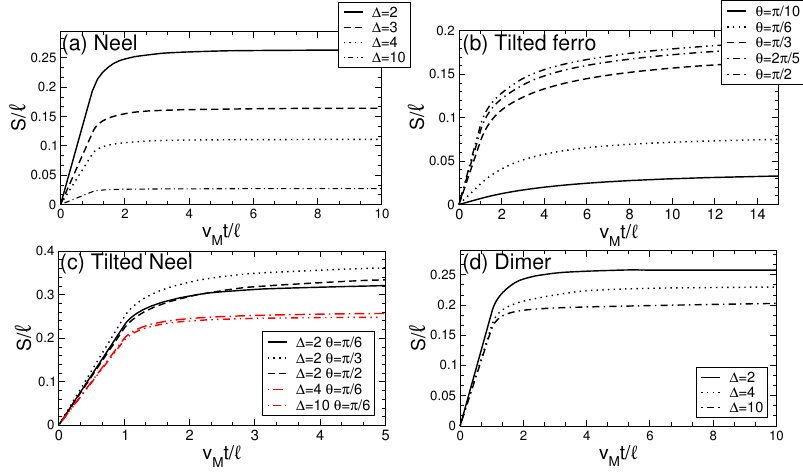
Figure 3: Group velocities of the low-lying excitations around the steady-state after a quench in the XXZ chain. All results are for chain anisotropy ∆ = 2. Group velocities are plotted against rapidity λ . Panels on different rows are for quenches from different initial states, namely the Néel state, the dimer state, and the tilted ferromagnet ( ϑ is the tilting angle). Different rows correspond to bound states of different sizes (strings) n = 1,2,3. For all quenches the maxi- mum velocity is obtained for n = 1 and the group velocity typically decreases upon increasing n .